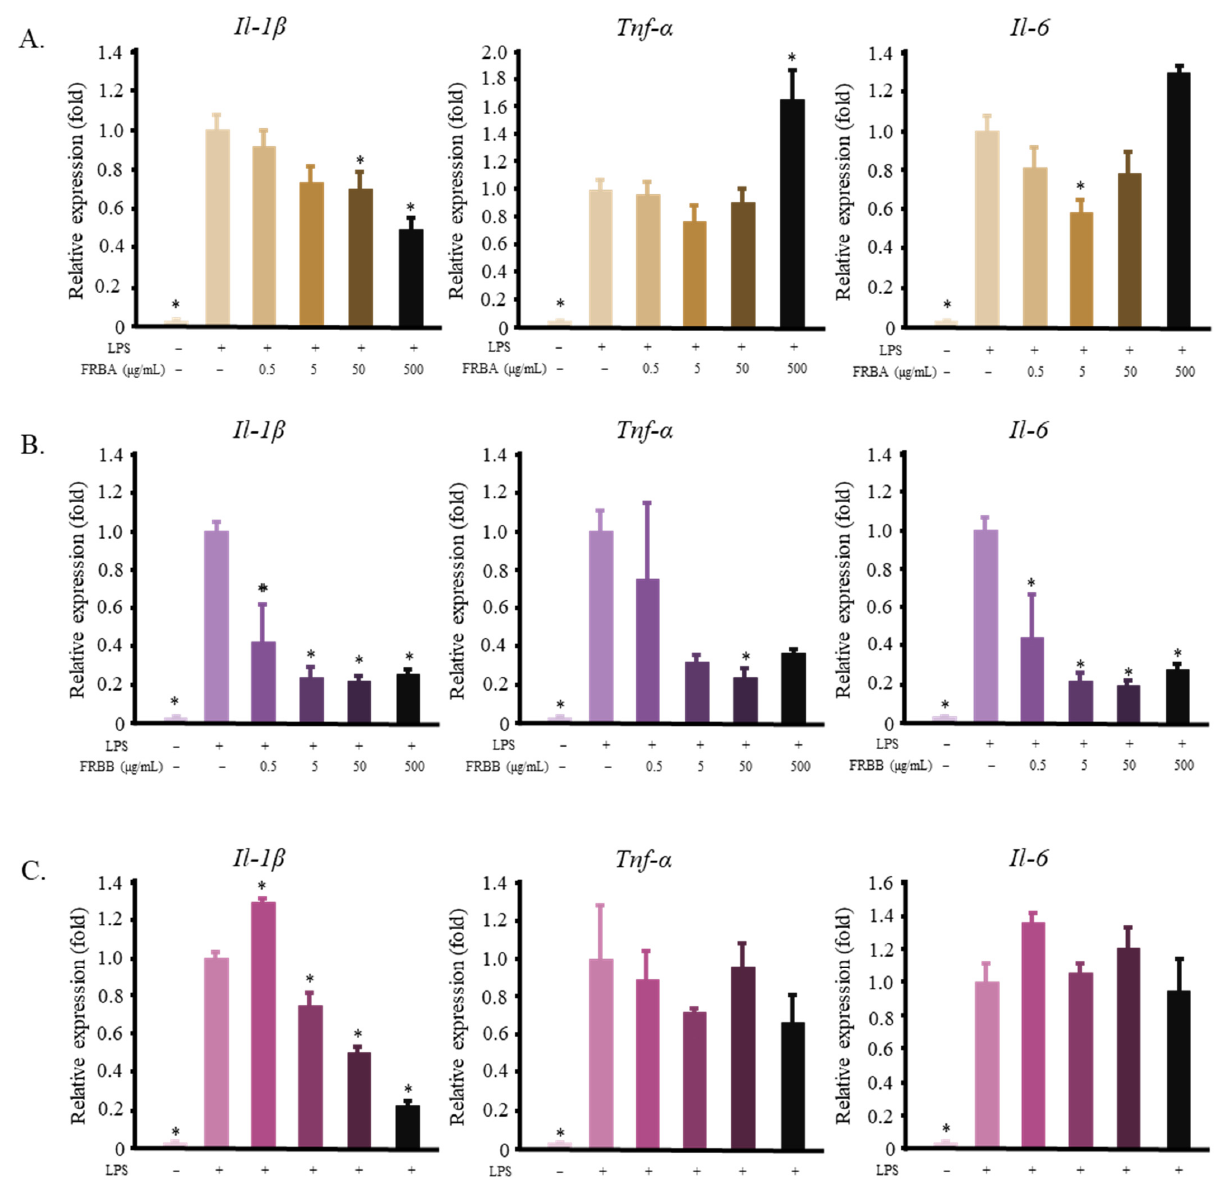
Figure 2. Solvent extraction of FRB results in fractions that reduce the mRNA level of pro-inflammatory cytokines in LPS-activated RAW 264.7 cells. ( A ) FRBA decreased the mRNA level of Il-1 β and Il-6 while increasing the level of Tnf- α ; ( B ) FRBB reduced the expression of Il-1 β , Tnf- α , and Il-6 ; ( C ) FRBC lowered the expression of Il-1 β but did not affect Tnf- α or Il-6 . The data are represented as mean ± SE, n = 3. Significant differences between the LPS group and the other groups (Dunnet’s analysis, p < 0.05) are marked with asterisks